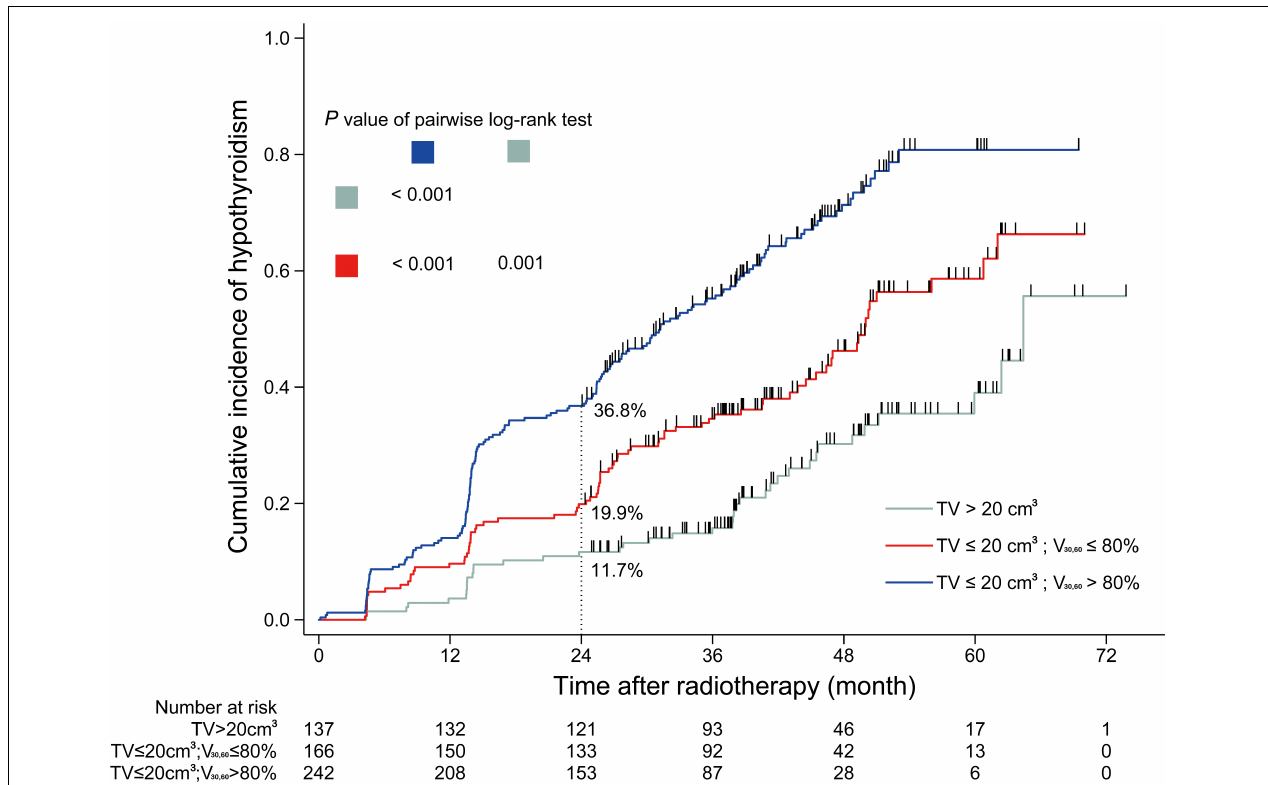
FIGURE 3 | Cumulative incidence curve of hypothyroidism for sub-cohorts. TV, thyroid volume; V 30 , 60 , the percentage of thyroid volume receiving irradiation doses of 30–60